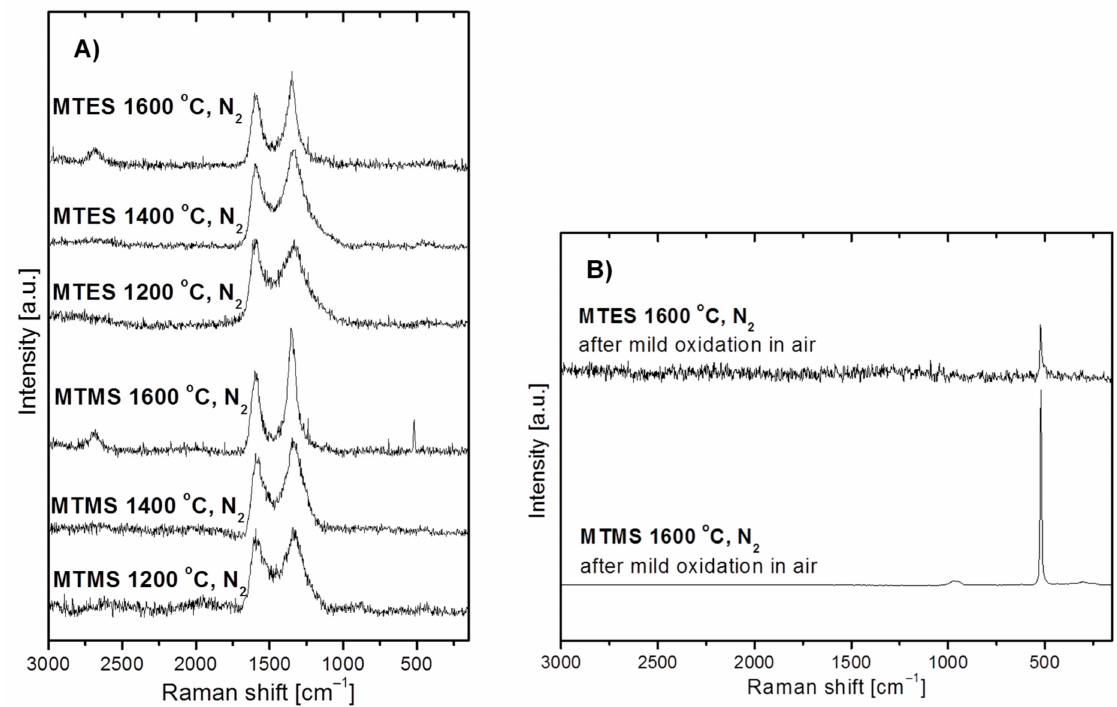
Figure 5. Raman spectra of powders produced by spray pyrolysis from MTMS and MTES in a nitrogen atmosphere. ( A )—as-produced powders, ( B )—selected powders after mild oxidation in